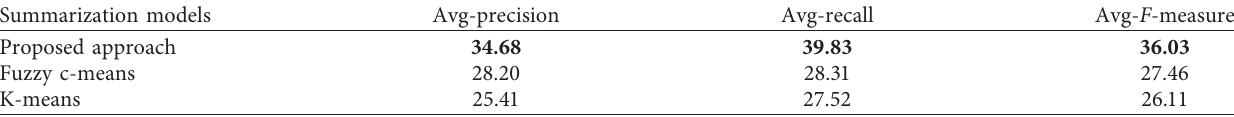
Table 1: Evaluation of summarization models on various measures using ROUGE-1 on Ubuntu dataset. Summarization models